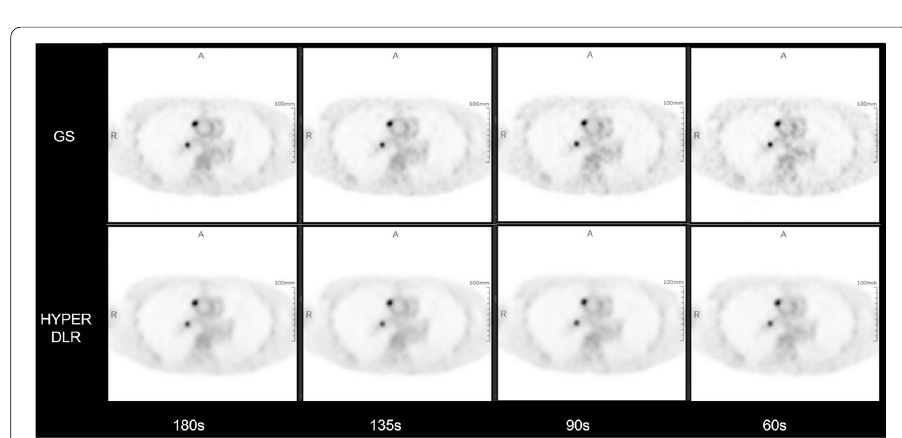
Fig. 4 Transverse images showing lymph node metastasis of a 61-year-old female patient with colorectal cancer. The upper and bottom row were reconstructed with GS and HYPER DLR algorithm, respectively. The acquisition time is 180, 135, 90, and 60 s (left to right). The bottom row indicates a performance equivalent to the one in the upper row regarding lesion detection with decreased image noise in the surrounding